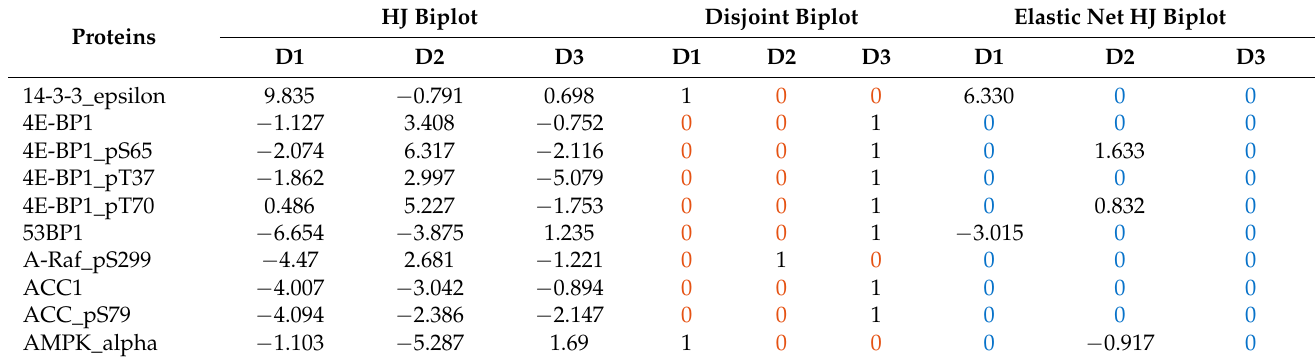
Table 1. Loadings matrix for the first three principal components obtained from the HJ biplot, DBiplot and the Sparse HJ biplot algorithms. To enhance the sparsity in each method, different fonts colors are used. HJ Biplot Disjoint Biplot Elastic Net HJ Proteins